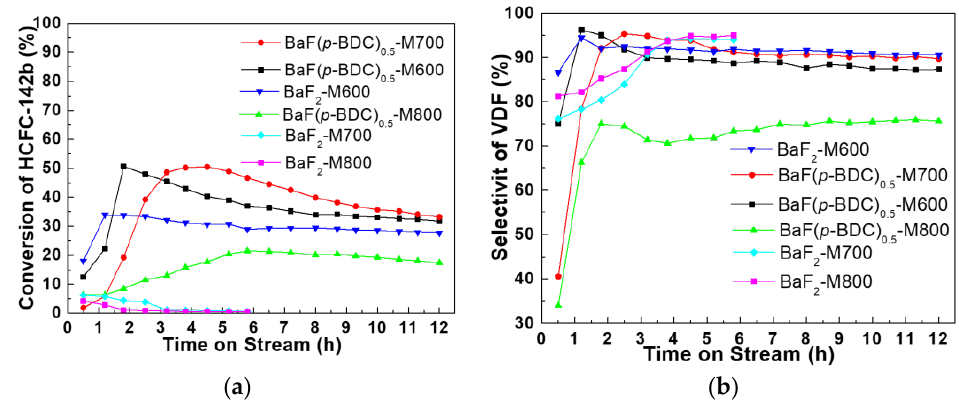
Figure 1. Catalytic performance of the BaF( p −BDC) 0.5 catalysts for the pyrolysis of HCFC−142b as a function of time on stream at atmospheric pressure, a gas hourly space velocity (GHSV) of 1200 h −1 , and a reaction temperature of 350 °C. ( a ) Conversion of HCFC−142b, ( b ) Selectivity to vinylidene fluoride (VDF).